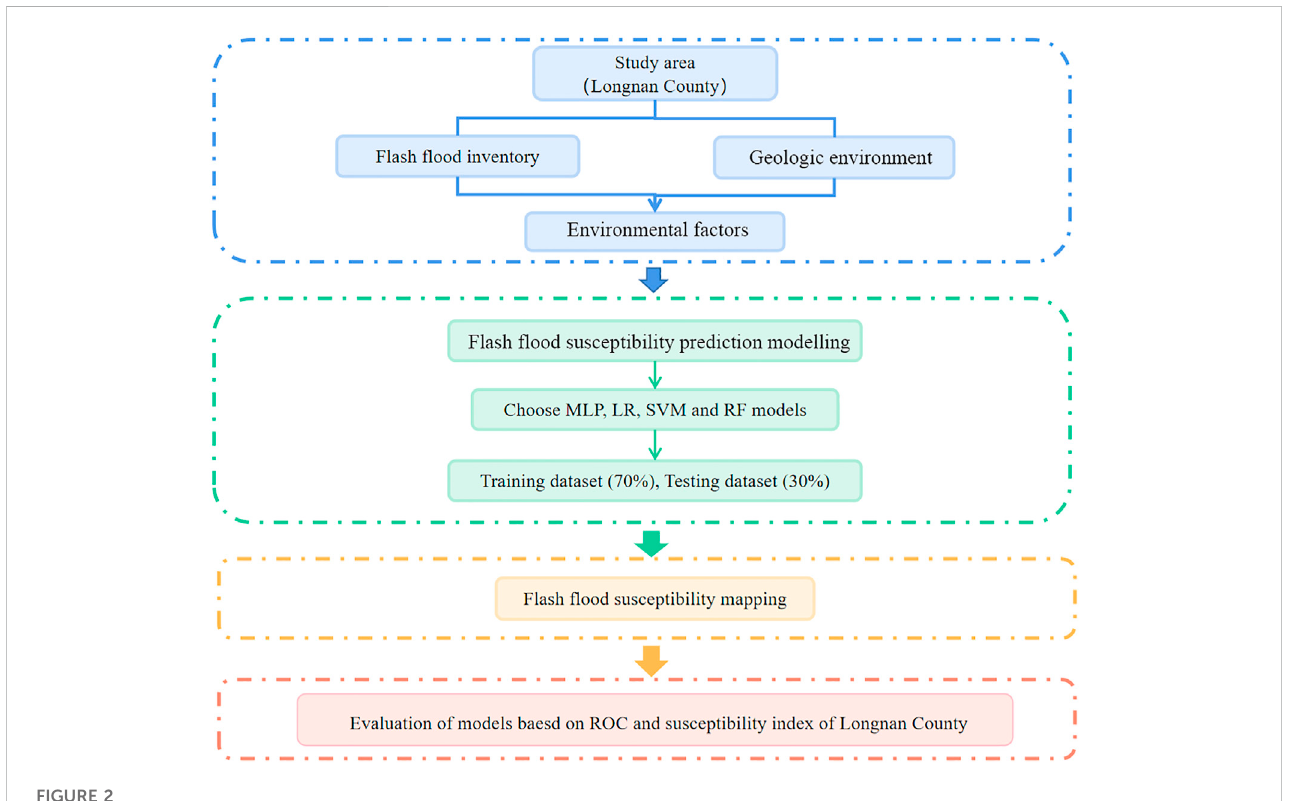
FIGURE 2 The fl ow chart of the research